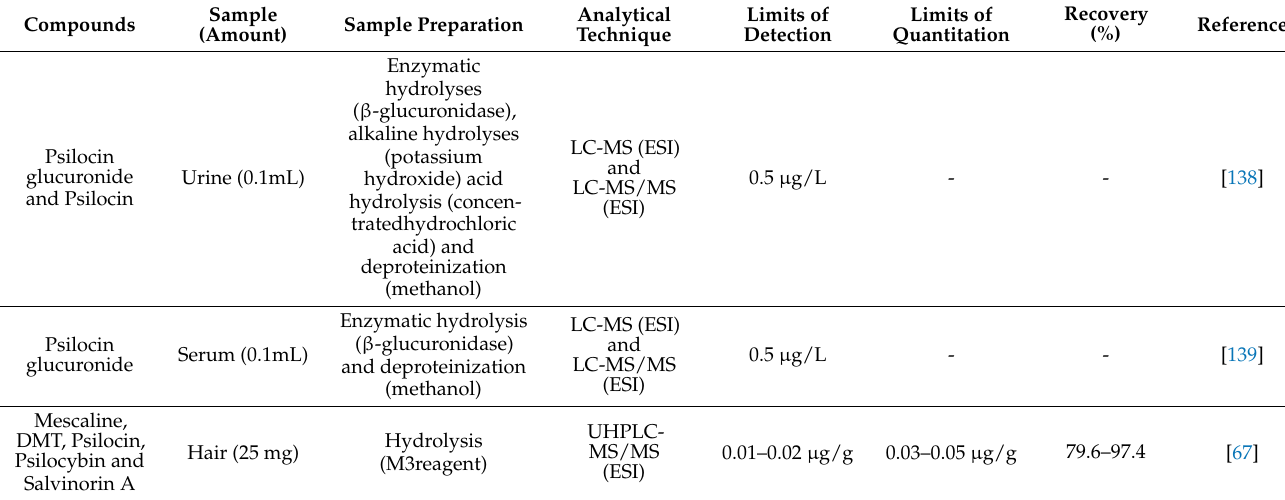
Table 7. Analytical methods for the determination of the main components of the Psilocybe